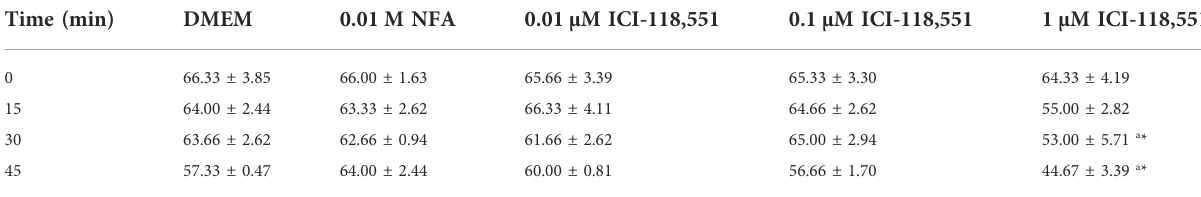
TABLE 2 Percent viability of sperm on exposure to different concentrations of ICI-118,551. Time